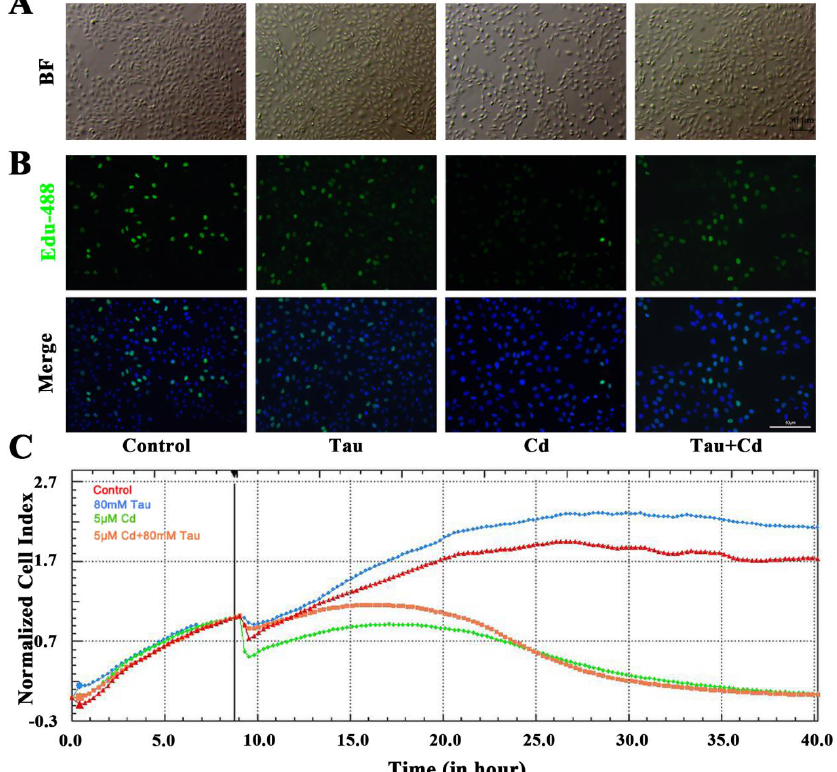
Figure 1. Tau can alleviate Cd-induced BRL3A cell damage. ( A ) Cd and Tau on cell morphology in BRL3A cells (scale bar = 50 µ m). BRL3A cells were treated with or without 80 mM Tau or 5 µ M Cd for 6 h; then, they were viewed and photographed under a Leica DMIRB. ( B ) Effect of Tau and Cd on cell proliferation in BRL3A cells (scale bar = 50 µ m). ( C ) Effect of Cd and Tau on cell index in BRL3A